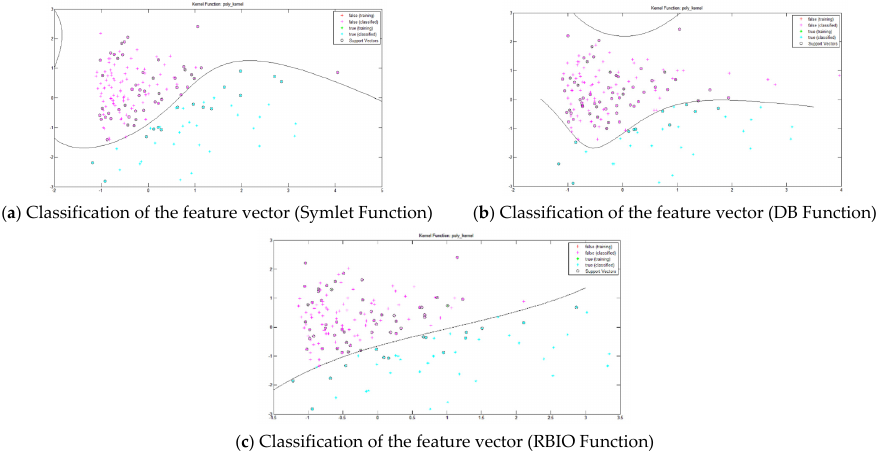
Figure 2. The classification of the feature vectors of the three different functions. ( a ) Classification of the feature vector (Symlet Function) ( b ) Classification of the feature vector (DB Function) ( c ) Classification of the feature vector (RBIO